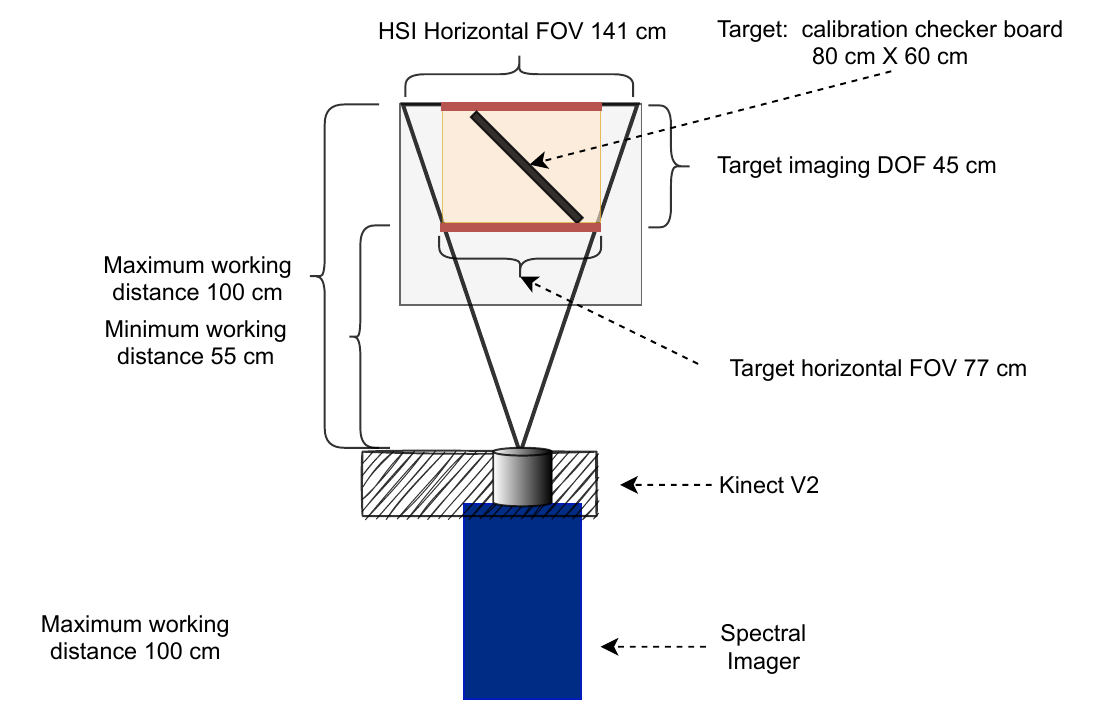
Figure 3. Selecting optics for the target scene. A visualization of the imaging setup parameters for achieving a similar vertical and horizontal field of view with HSI and Kinect V2 sensors.